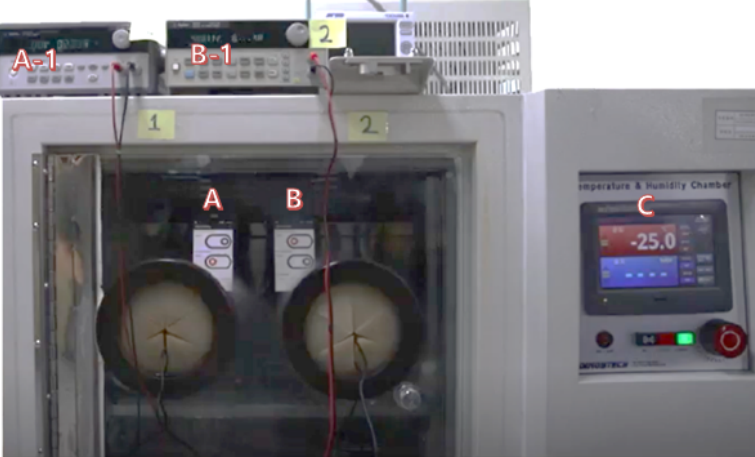
Figure 13. Cold-chamber experiment (A: Terminal with existing method; B: Terminal with edge AI method; A-1 and B-1: DC power supplies for measuring the current at Terminal A and B, respectively; C: Cold-chamber controller maintaining − 25 ◦